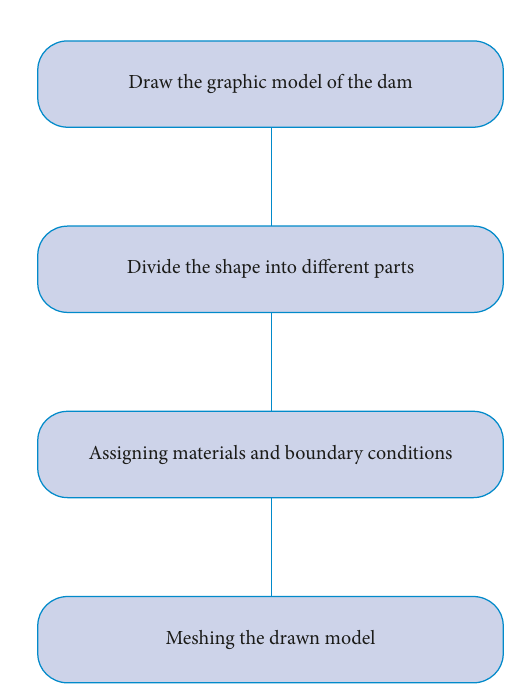
Figure 5: The general steps of modeling.